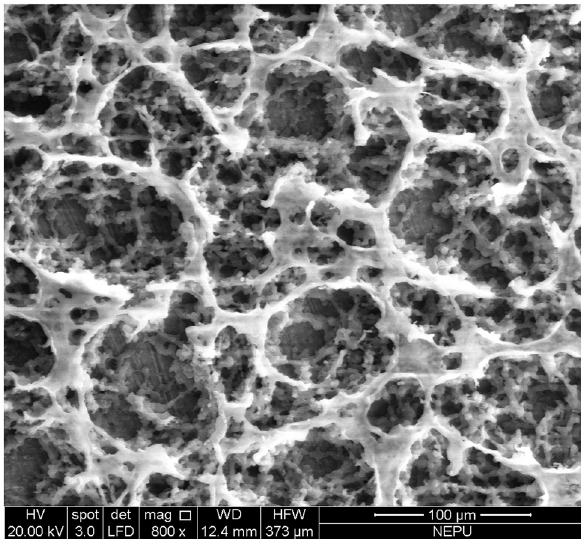
Figure 3: SEM images of the original foaming agent.